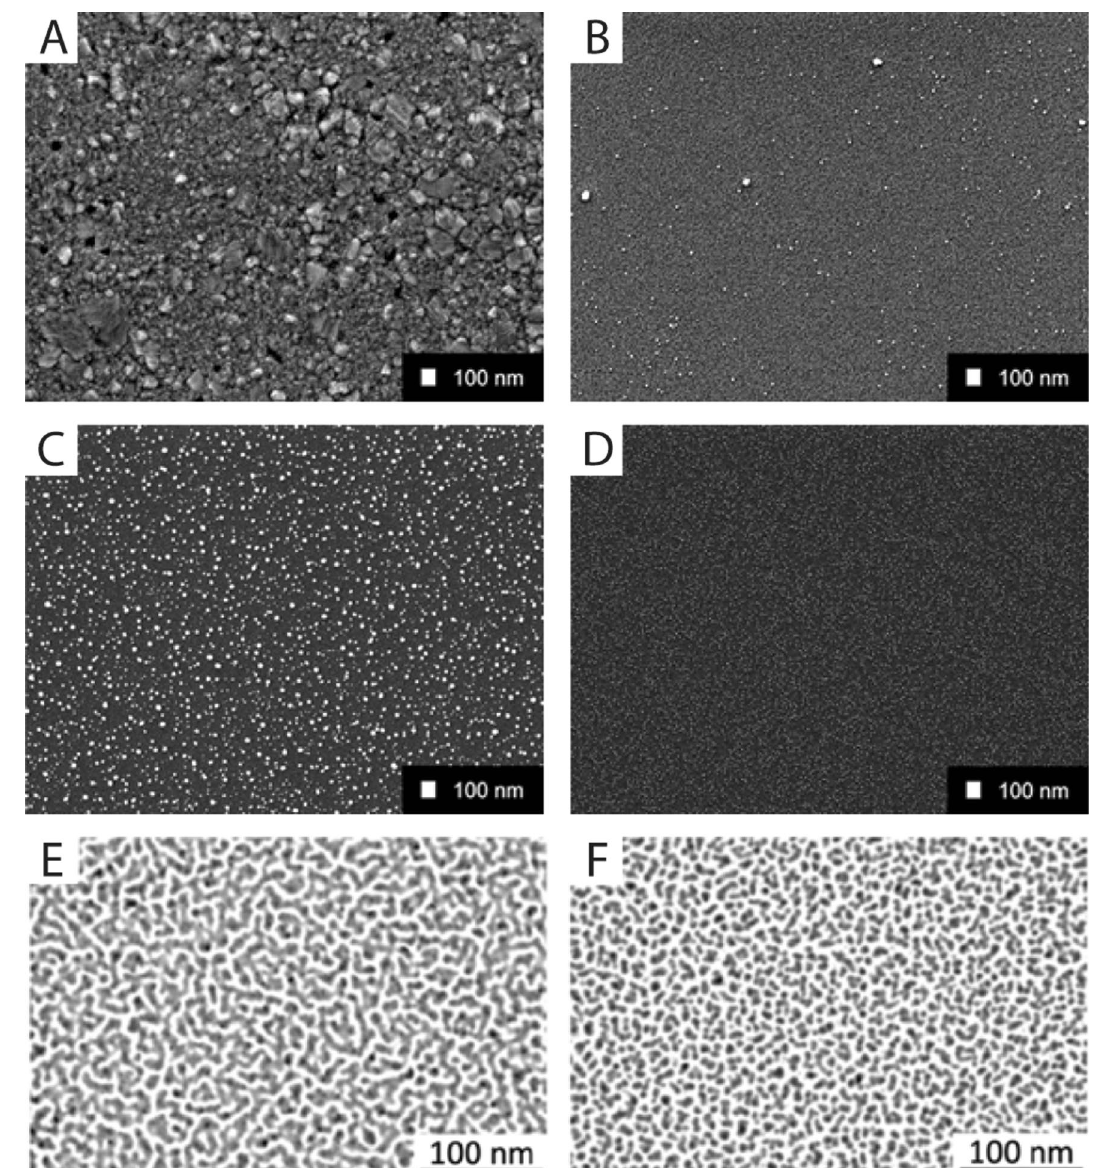
Figure 2. Exemplary electron microscopy images of continuous nanoscale films ( A , B ) and nanopatches ( C – F ). ( A ) SEM top view of 50 nm Ag, ( B ) SEM top view of 50 nm Cu, ( C ) SEM top view of Ag nanopatches sputtered for 60 s, ( D ) Ag & Pt nanopatches co-sputtered for 60 s, ( E ) TEM image of Ag & Cu nanopatches co-sputtered for 60 s on a TEM grid, ( F ) Cu on Ag nanopatches sequentially sputtered for 60 s on a TEM grid. ( E , F ) taken from reference 18